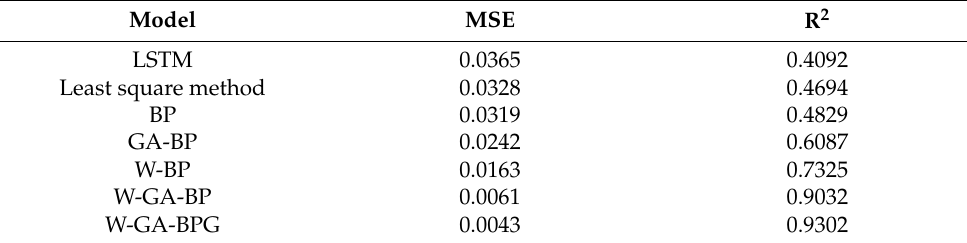
Figure 8. Errors comparison between the predicted value and true value with different models. Table 11. Comparison of evaluation indexes of prediction models.